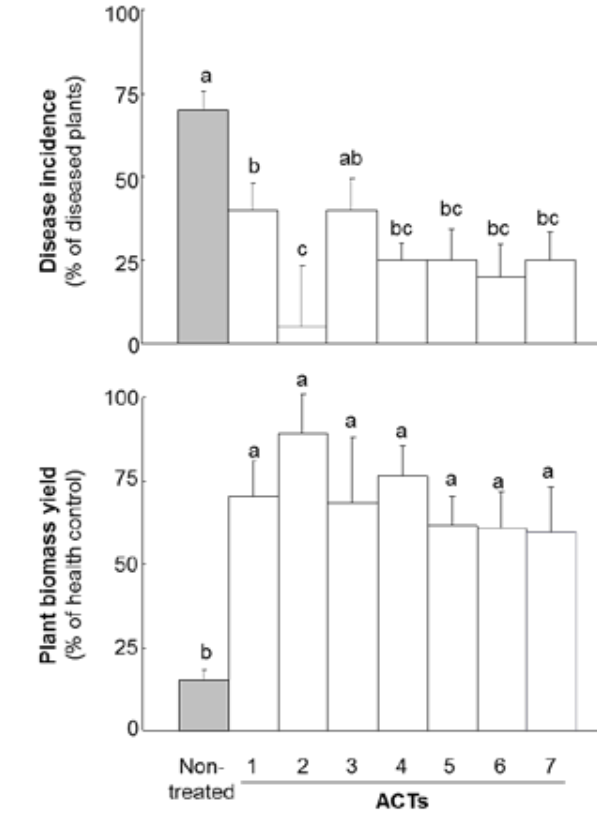
Figure 4. Mean lettuce drop incidence and mean plant biomass (±1 SE) for lettuce plants drenched with different aerated compost teas (ACTs), growing in media inoculated with Sclerotinia minor. Different letters indicate significant differences ( P ≤0.05) according to Duncan’s